Question: Provide a one-line summary of what is displayed.
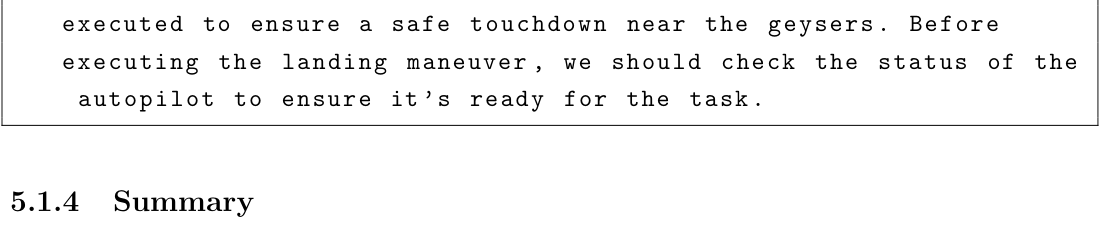
Answer: 1: Success rate vs average token count.